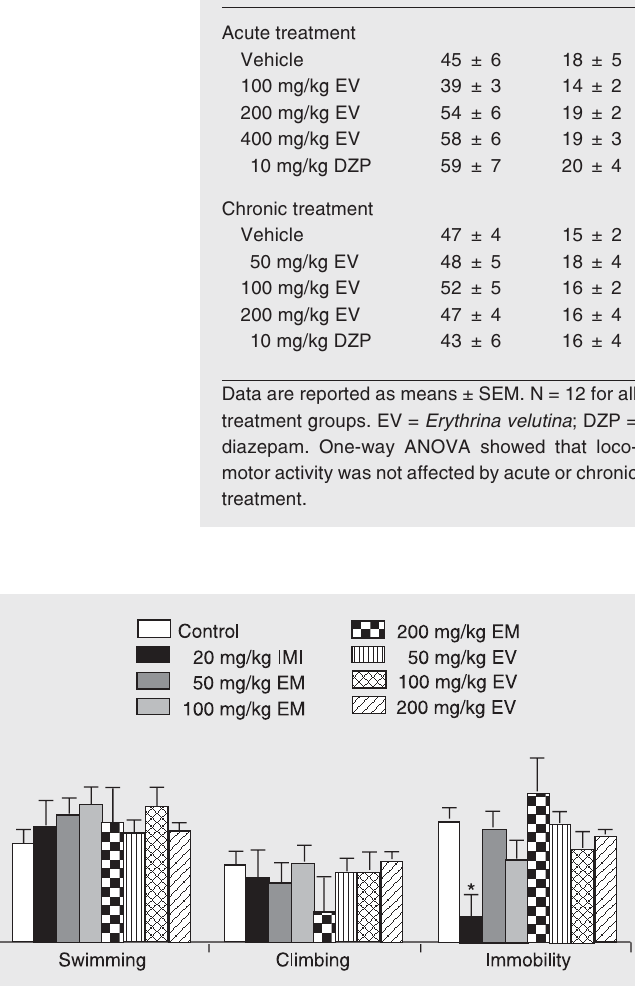
Figure 3. Effect of chronic oral administration of two water-alcohol extracts of Erythrina mulungu (EM), E. velutina (EV) and imipramine (IMI) on the behavior of rats submitted to the forced swim test. Data are reported as means ± SEM. N = 10 for all treatment groups. *P < 0.05 compared to control